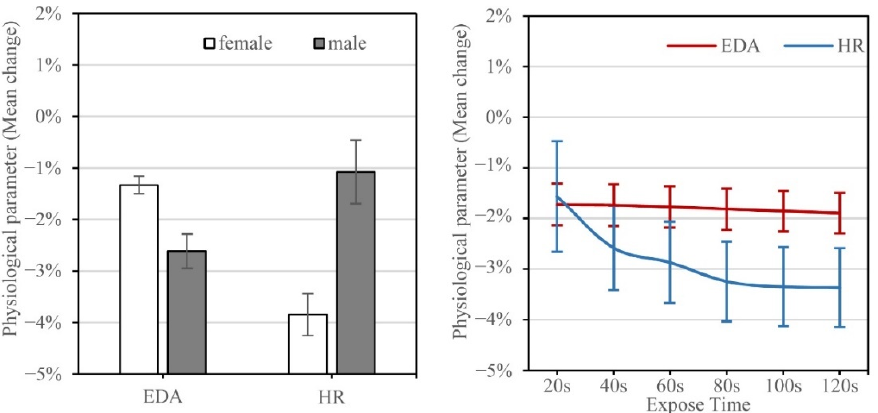
Figure 8. Effect of gender and exposure time on physiological responses to traffic sounds. The vertical bars represents 95% confidence intervals.